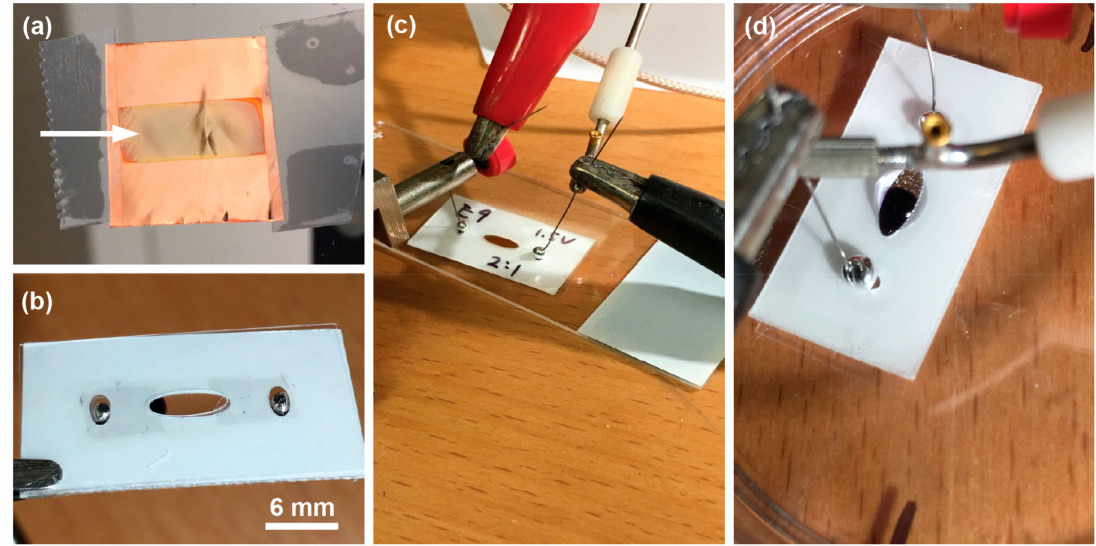
Figure 1. Schematic illustration of the fabrication scheme and device architecture for thin-film graphene-based microfluidics. ( 1 ) A patterned graphene film on copper is first coated with a layer of poly(methylmethacrylate) (PMMA), and then released from the copper substrate by etching. The subsequent film is floated on the surface of water for transfer to either an adhesive-backed polyester film that defines the crystallization chamber, or a cyclic olefin copolymer film to form the top layer of the device. ( 2 ) Assembly of the device proceeded with the application of a COC bottom layer to the crystallization layer assembly to provide additional stability. Following the addition of the crystallization solution, the device is then sealed with the COC top layer. Electrical contact to the graphene electrodes is made using a liquid alloy, and the electrocrystallization experiment can take place.